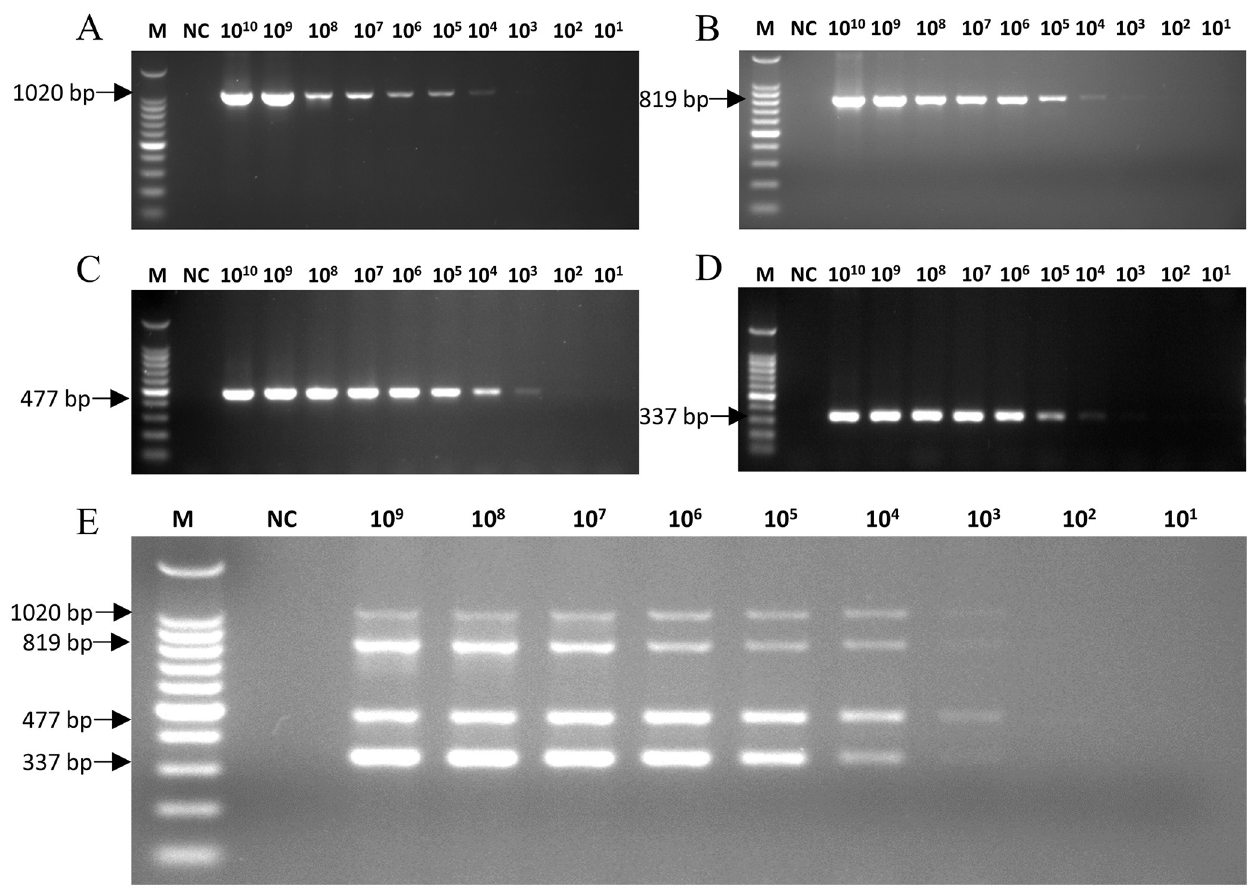
Fig 4. Sensitivity of the mPCR method for CEV detection. The four single plasmids (pMD-CAV-2, pMD-CanineCV, pMD-CCoV and pMD-CPV), diluted from 1 × 10 10 to 1 × 10 1 copies/ μ l, and the mixed plasmids (pMD-CAV-2/pMD-CanineCV/pMD-CCoV/pMD-CPV), diluted from 1 × 10 9 to 1 × 10 1 copies/ μ l, were used to determine the minimum detection limit of the CEV mPCR method. (A) The sensitivity of pMD-CAV-2; (B) the sensitivity of pMD-CanineCV; (C) the sensitivity of pMD-CCoV; (D) the sensitivity of pMD-CPV; (E) the sensitivity of pMD-CAV-2/pMD-CDV/pMD-CIV/pMD-CPIV; Lane M, 100 bp DNA ladder; Lane NC, negative